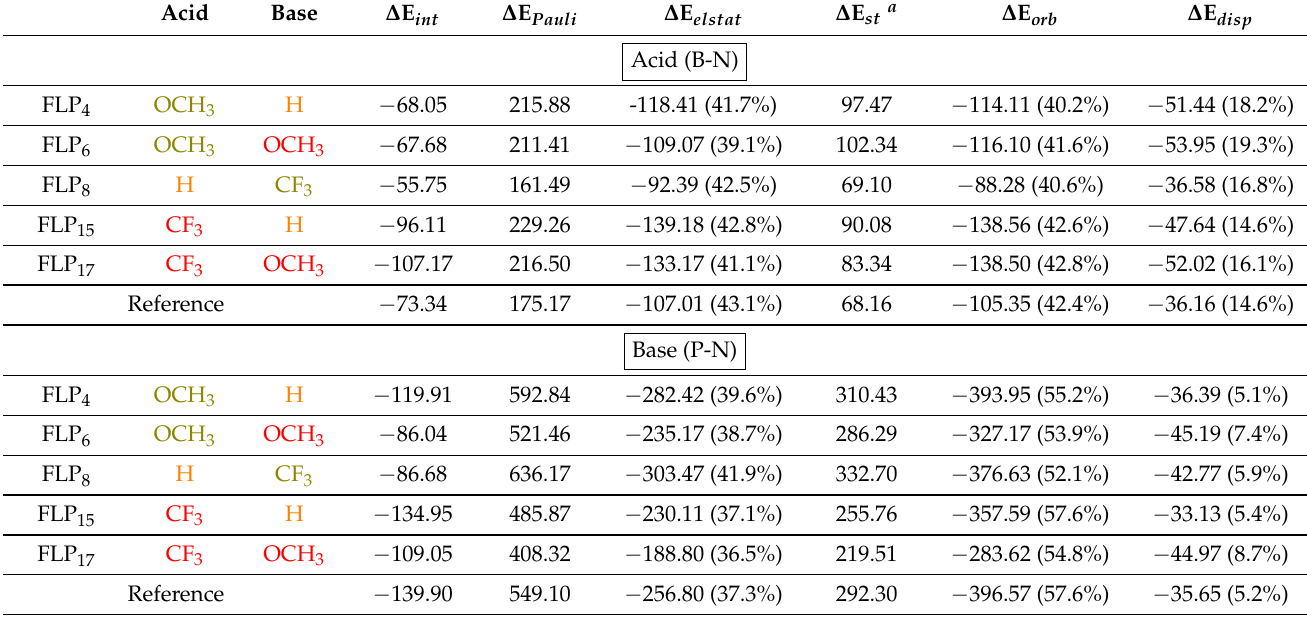
Table 4. Interaction energy ( ∆ E int ), Pauli repulsion ( ∆ E Pauli ), electrostatic interaction ( ∆ E elstat ), steric energy ( ∆ E st ), orbital attraction ( ∆ E orb ) and dispersion energy ( ∆ E disp ), in kcal/mol, for the B-N (acid–DEAD) and P-N (base–DEAD) bonds. Values in brackets are the percentage contributions to the total attractive interactions: ∆ E elstat + ∆ E orb + ∆ E disp